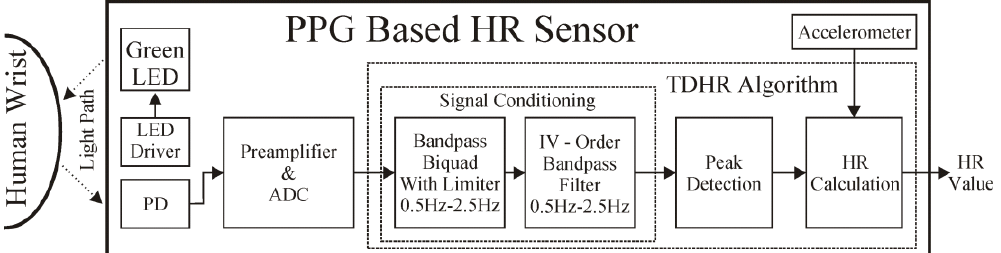
Figure 3. Block diagram of PPG signal acquisition, preprocessing, and final HR estimation by TDHR algorithm.